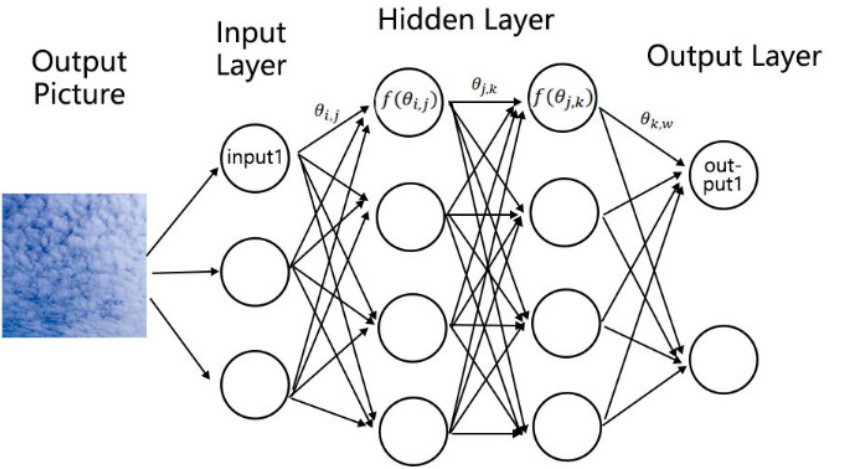
Figure 7. In the traditional neural network (NN) architecture, a node represents a neuron, θ represents the weight parameter of the layer, and f ( θ ) represents the activation function used by the neuron. NN is fully connected, where each neuron is connected to all neurons in the next layer.